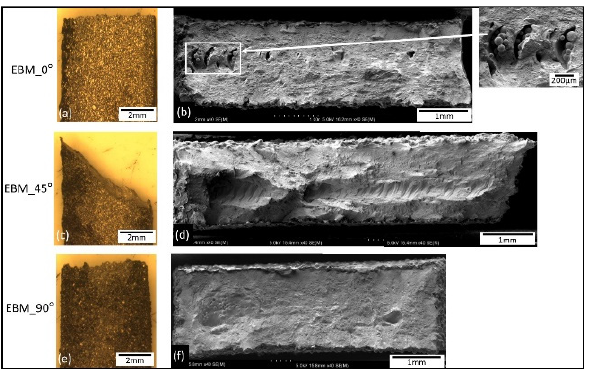
Figure 12. Macrographs showing side view of the tensile tested samples ( a , c , e ) and low magnification images of the fracture surfaces of the EBM samples ( b , d , f ). Note the un-melted particles on EBM_0° also reported in [16,20,37].